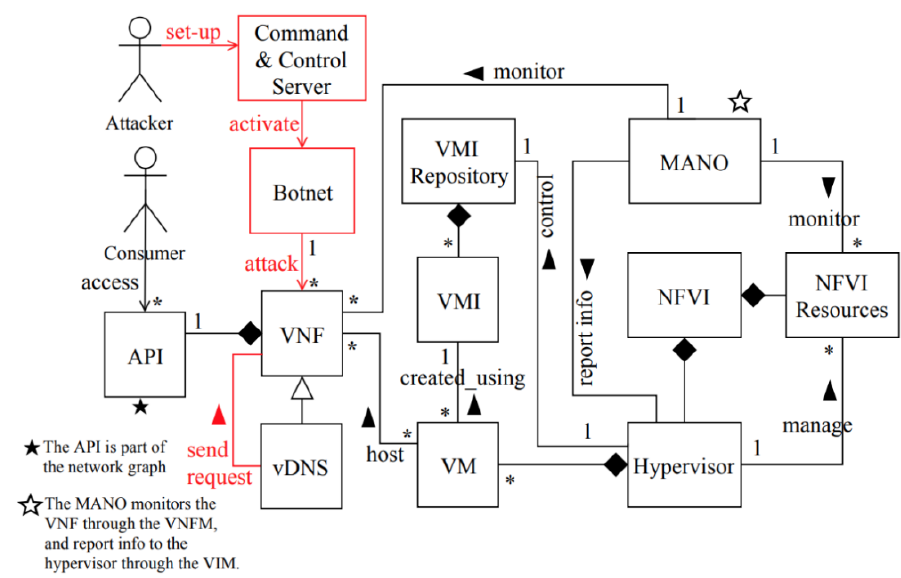
Figure 8. Class diagram for DDoS attack in NFV [13].